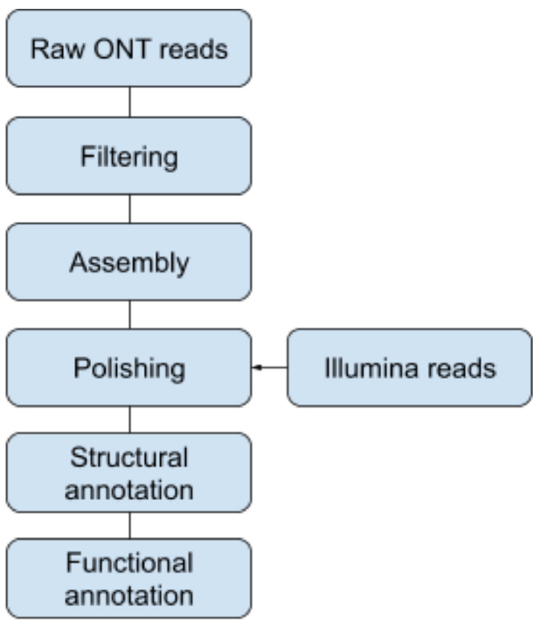
Figure 1. Overview of the assembly workflow. Raw ONT reads were filtered followed by a draft assembly. The assembly was curated using Illumina reads.